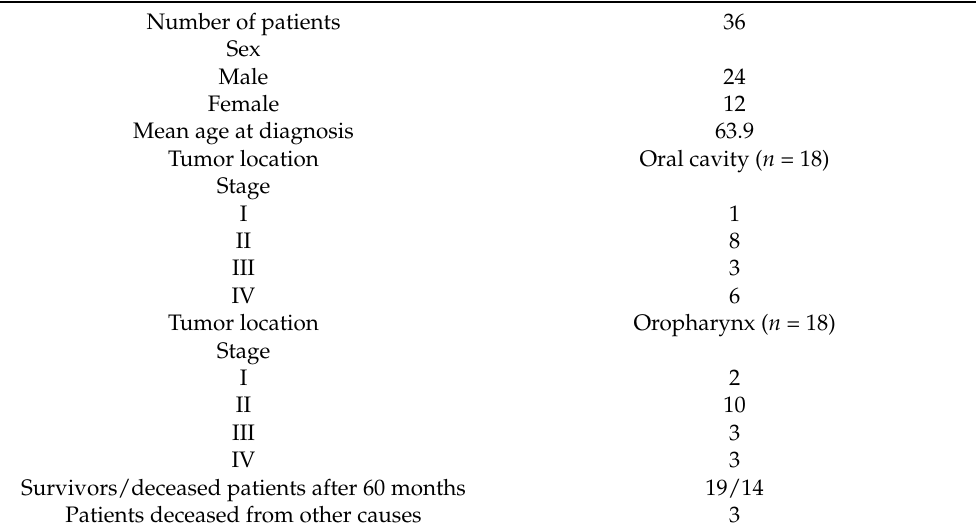
Table 1. Clinical